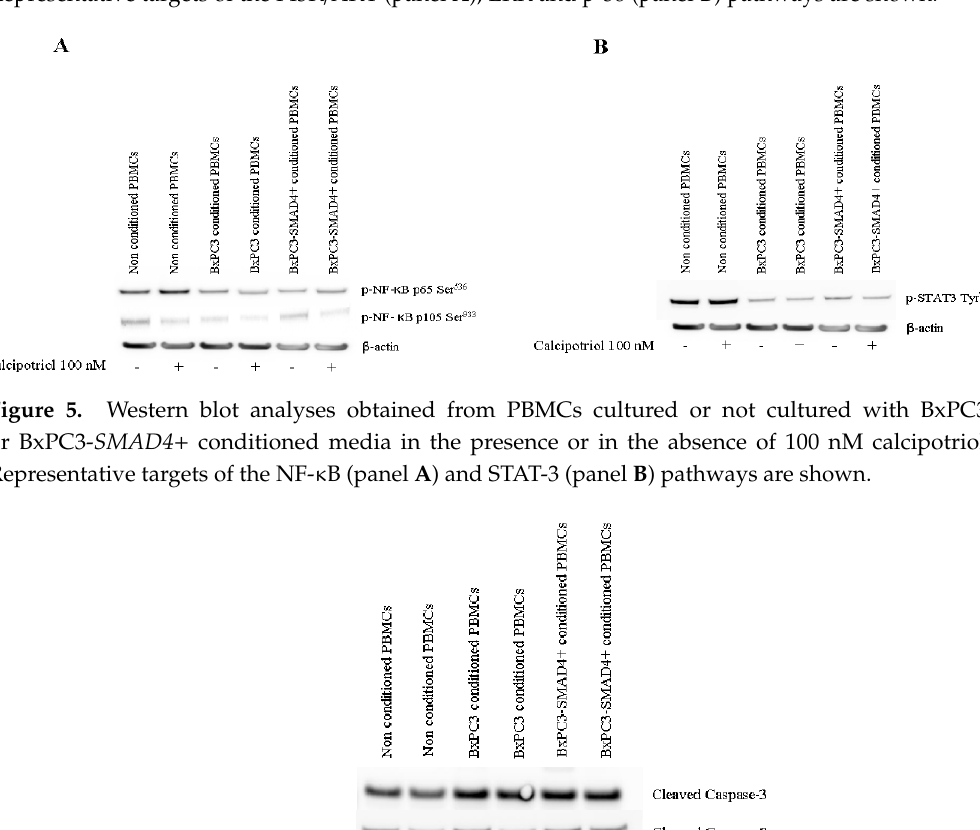
Figure 7. Western blot analyses obtained from BxPC3 or BxPC3- SMAD4+ cell lines in the presence or in the absence of 100 nM calcipotriol. Representative targets of ERK and p-38 (panel A ), NF- κ B (panel B ), I κ B- α (panel C ), PI3K/AKT (panel D ), STAT-3 (panel E ), and Caspase (panel F ) pathways are shown. 4. Discussion The microenvironment is known to play a relevant role in the proliferation of pancreatic cancer and metastatic spread. Tumoral and stromal inflammatory cells interact and reciprocally modify their phenotype [20]. Tumor cells might shape the microenvironment, favoring a shift towards immunosuppression through the release of soluble or exosome-carried cytokines, chemokines and